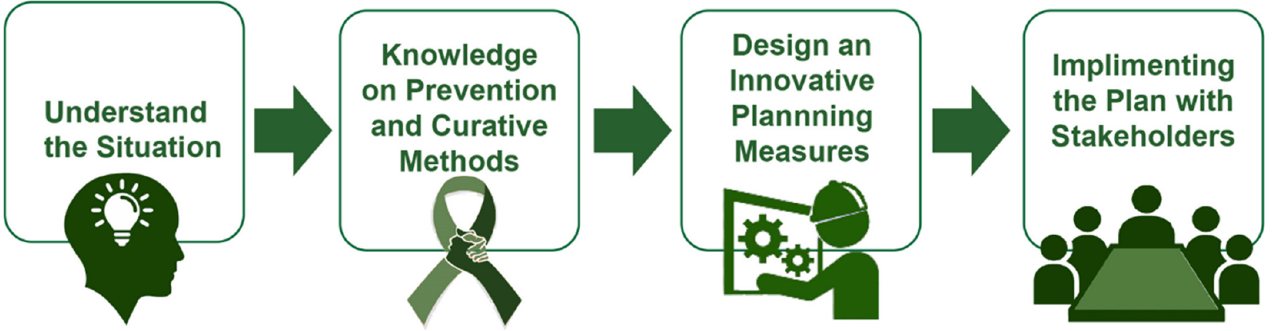
Figure 9. Adaptive resilient planning process; Source: authors, 2022.